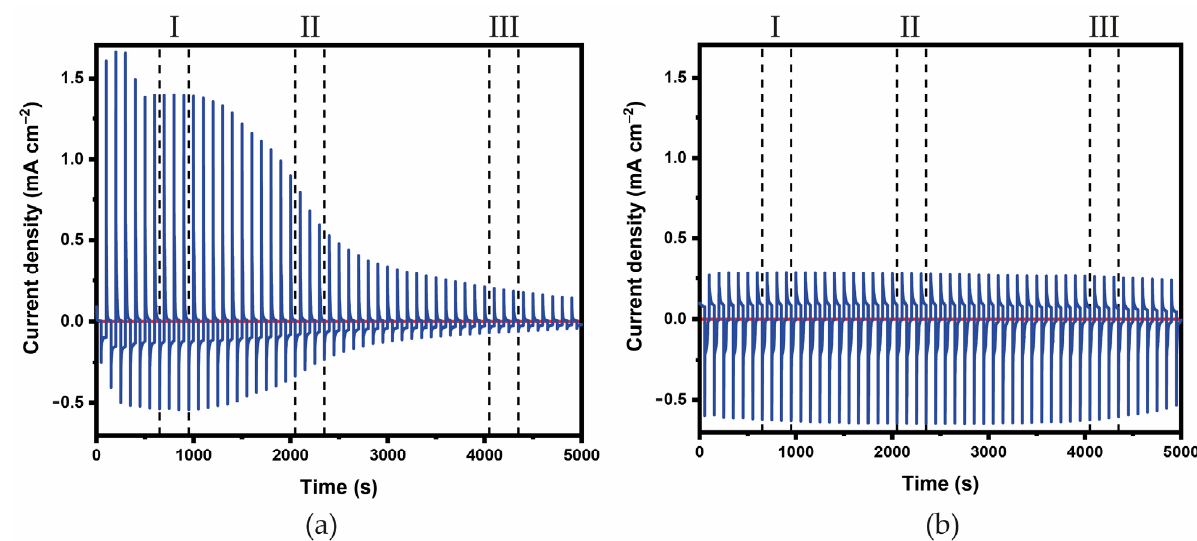
Figure 6. Current density (mA·cm − 2 ) as a function of time (s) for the ECD1 ( a ) and ECD2 ( b ) The voltage steps applied up to ±3.0 V. The dashed lines are the time intervals at which the CE values were measured and calculated. Figure S4 shows a zoom of these values.